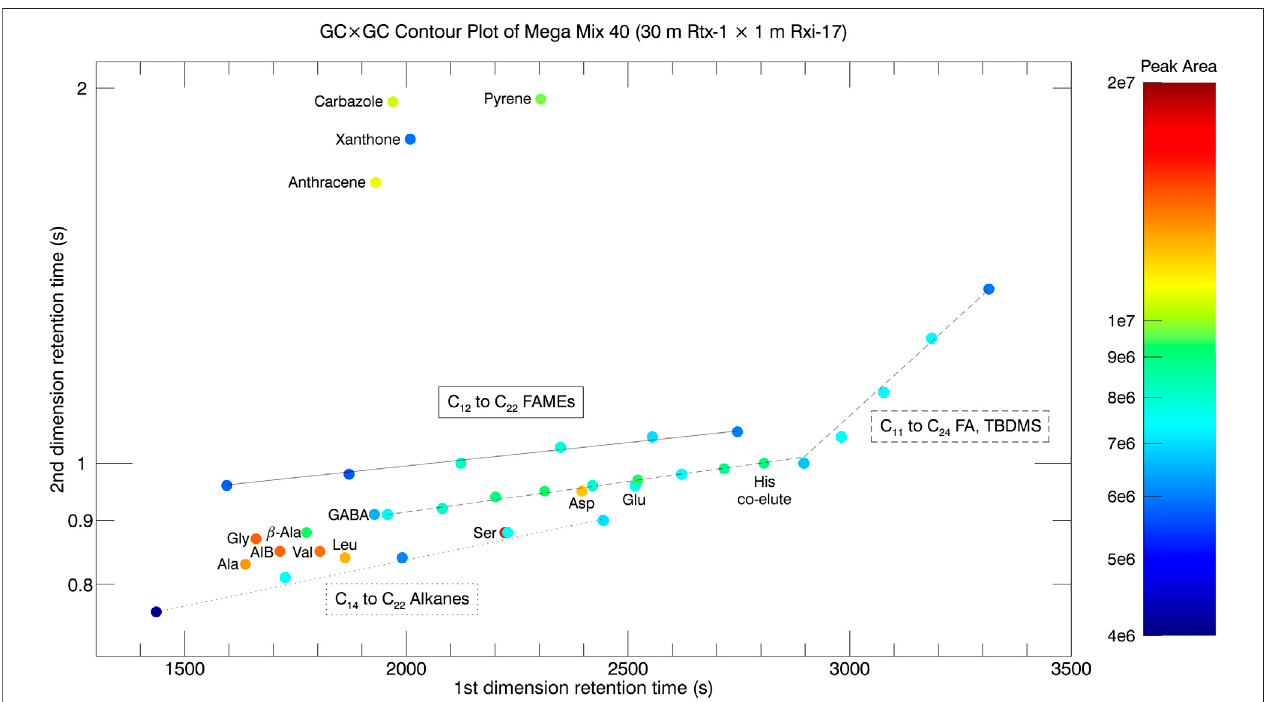
FIGURE 8 | GC × GC contour plot of Mega Mix 40 taken on a 30 m Rtx-1 × 1 m Rxi-17 column con fi guration. The two-dimensional retention space shows the increased resolving power and peak capacity provided by GC × GC. The peak area contour values are shown at right. Chemical family groupings, or speciation, are depicted by the trendlines and labels for the species that fall on these trendlines. Amino acid derivatives are individually labeled since they do not fall along a simple trend